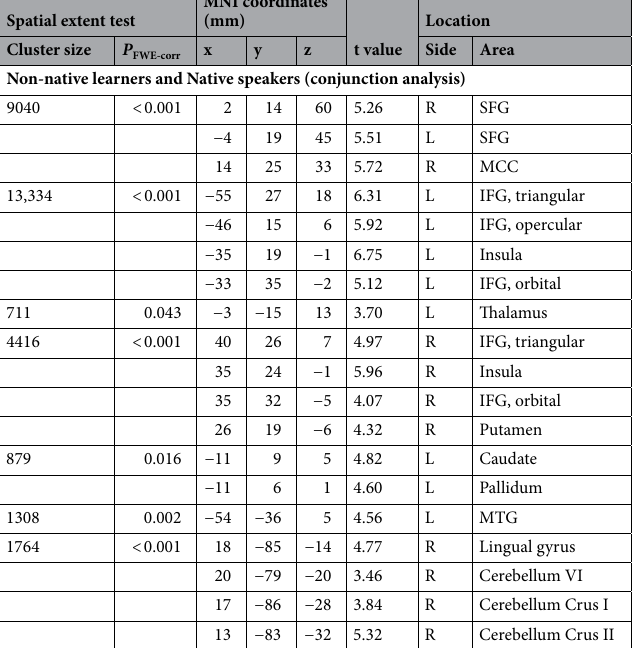
Table 2. Regions associated with grammar processing for non-native learners and native speakers. Activation was set at a threshold value of p < 0.05 and FWE was corrected for multiple comparisons over the whole brain, with the height threshold set at p < 0.001, uncorrected. The terms x, y, and z represent the stereotaxic coordinates (mm). R, right hemisphere; L, left hemisphere; IFG, inferior frontal gyrus; SFG, superior frontal gyrus; MCC, middle cingulate cortex; MTG, middle temporal gyrus; MNI, Montreal Neurological Institute.